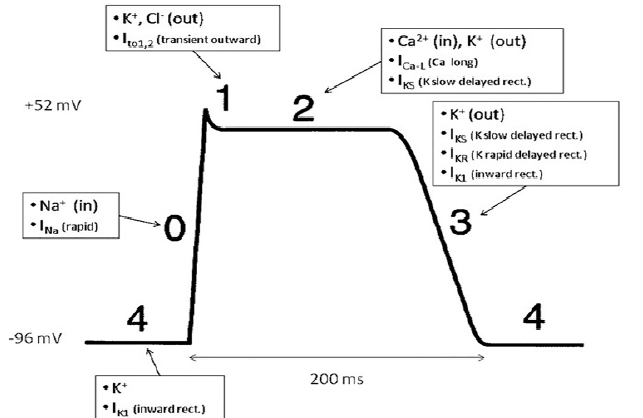
Figure. Cardiac Myocyte Action Potential. Slow delayed